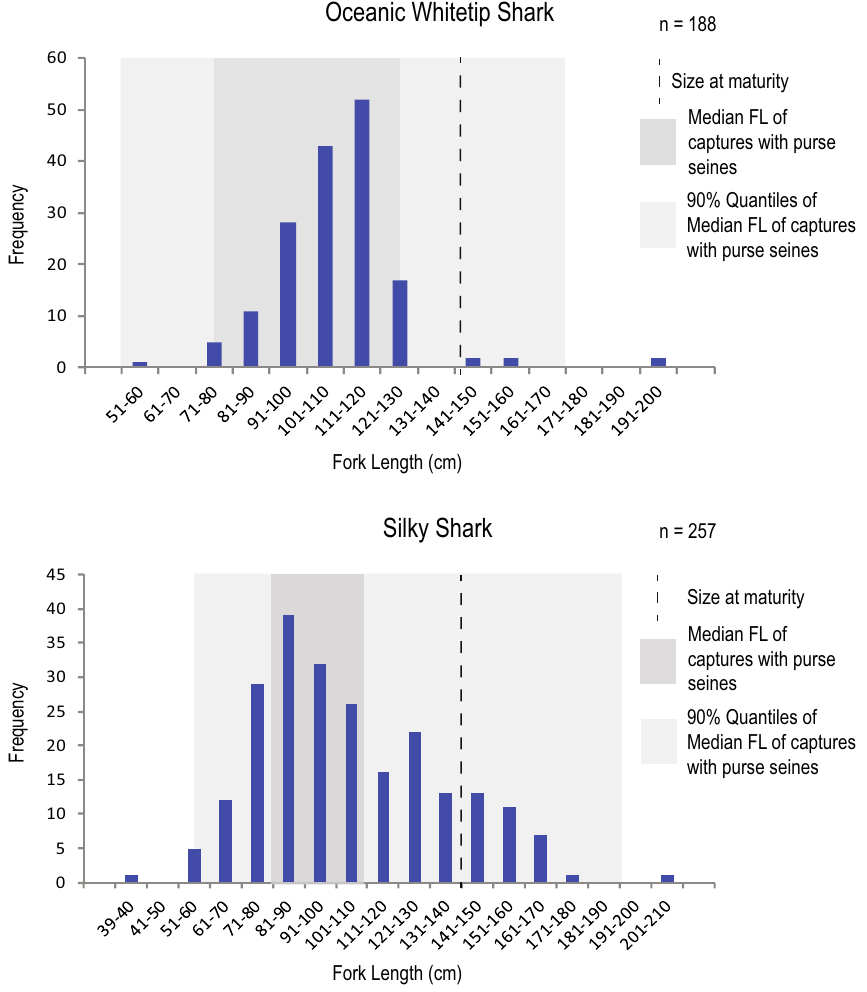
Figure 3. Size structure for oceanic whitetip and silky sharks seized in vessel Fu Yuan Yu Leng 999 (based on 188 and 257 individuals, respectively). Size to maturity for oceanic whitetip was based on Joung et al. 39 , by transforming Total Length to Fork Length 49 . Median Fork Length of captures with purse seines and